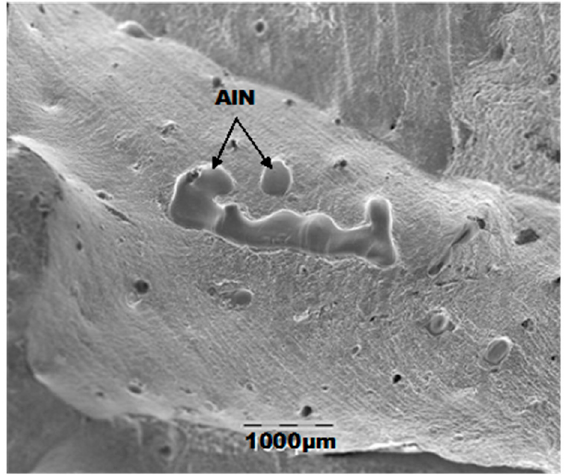
Figure 7. Room temperature fracture surface of a high Al, TWIP steel (0.6C, 18Mn 1.6Al, 0.007N)